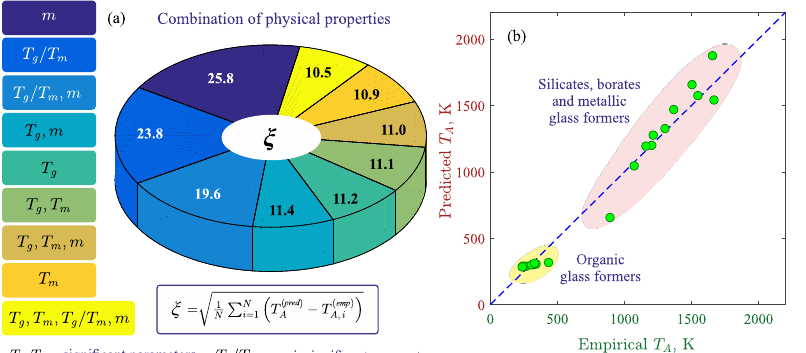
Figure 2. ( a ) Diagram of the root mean square error ξ of estimation of the Arrhenius crossover temperature T A calculated for various combinations of the quantities T m , T g , T g / T m and m , which were the inputs of the machine learning model. Inset: T empirical Arrhenius crossover temperatures, respectively. ( b ) Correspondence between the empirical T A and the T A predicted by the machine learning model using the validation data